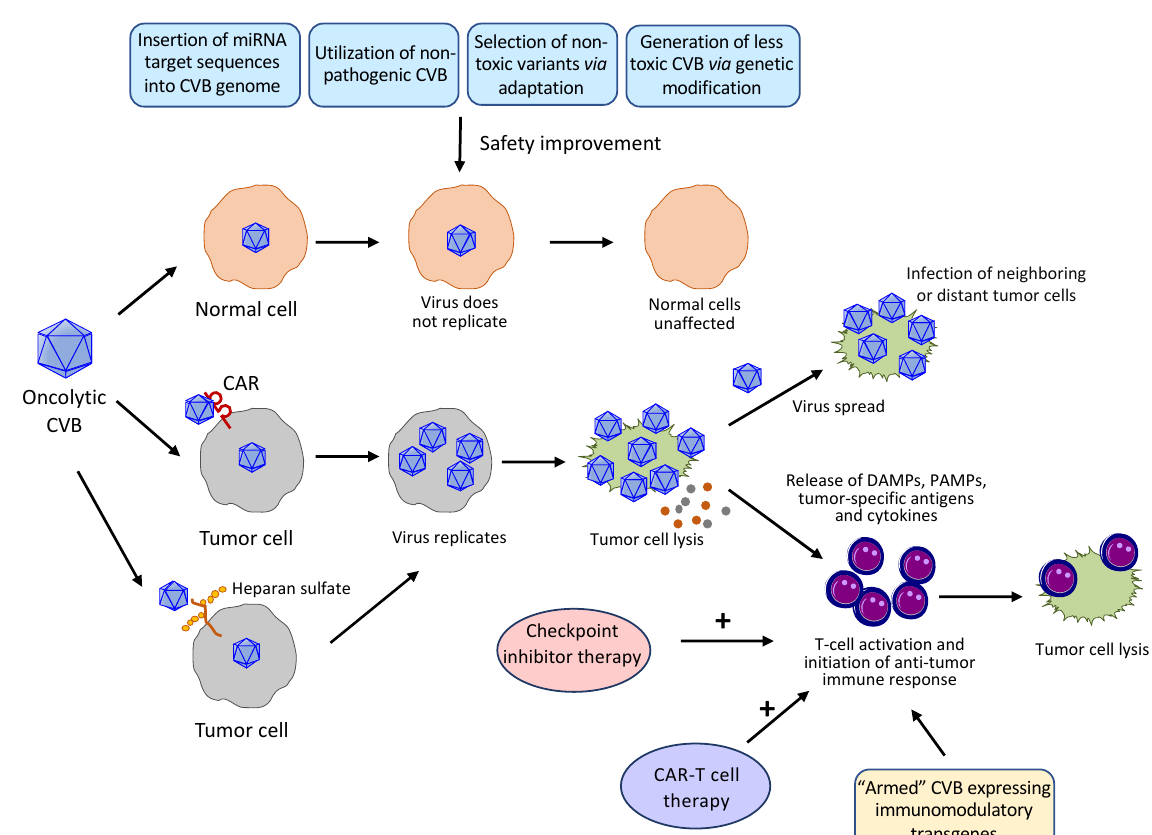
Figure 3. Mechanism of action and strategies applied or proposed to enhance the safety and potency of oncolytic CVBs. CVBs preferentially replicate in and kill tumor cells with limited replication and lysis capacity in healthy cells. Several approaches have been or may be used to further improve the safety profile of CVBs, including insertion of organ-specific/tumor-suppressive miRNA target sequences to viral genome, utilization of non-pathogenic strains of CVBs, selection of non-toxic CVB variants through directed evolution, and production of less toxic CVBs by genetic modification. CVBs enter tumor cells through the coxsackievirus-adenovirus receptor (CAR, primary receptors for all CVBs) and/or heparan sulfate (the PD strain of CVB3). After replication, oncolytic CVBs induce tumor cell lysis, leading to the release of viral progeny that can infect adjacent and distant tumor cells, and the leakage of danger-associated molecular patterns (DAMPs), pathogen-associated molecular patterns (PAMPs), tumor-associated antigens, and cytokines to modulate the tumor microenvironment and activate systemic anti-tumor immune response. A combinational treatment of oncolytic CVB with an immunotherapy, such as checkpoint inhibitor and CAR-T cell therapy, or use of “armed” recombinant CVBs that express immunomodulatory transgenes are expected to yield an additive anti-tumor